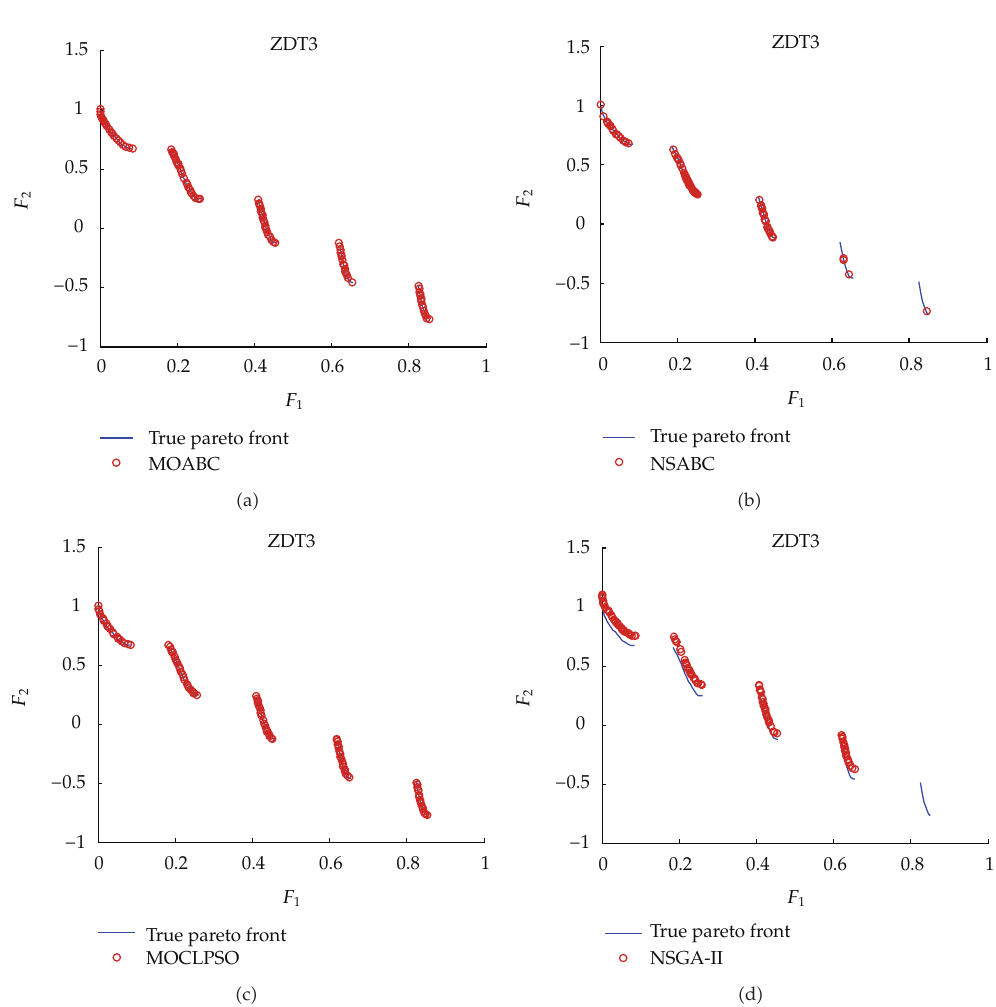
Figure 10: Pareto fronts obtained by NSABC, MOABC, MOCLPSO, and NSGA-II on ZDT3 after 20000 FEs.